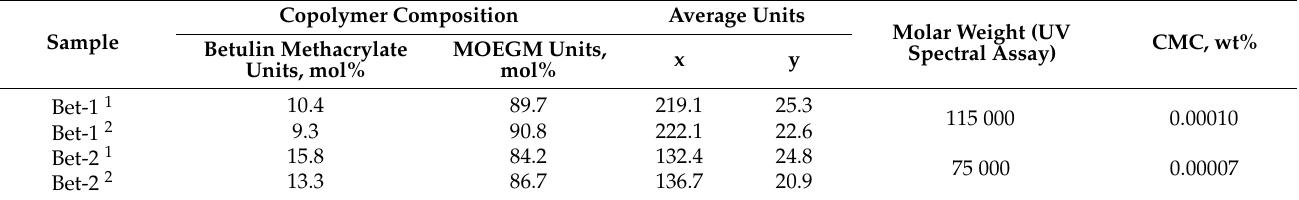
Table 1. Characteristics of Bet-1 and Bet-2